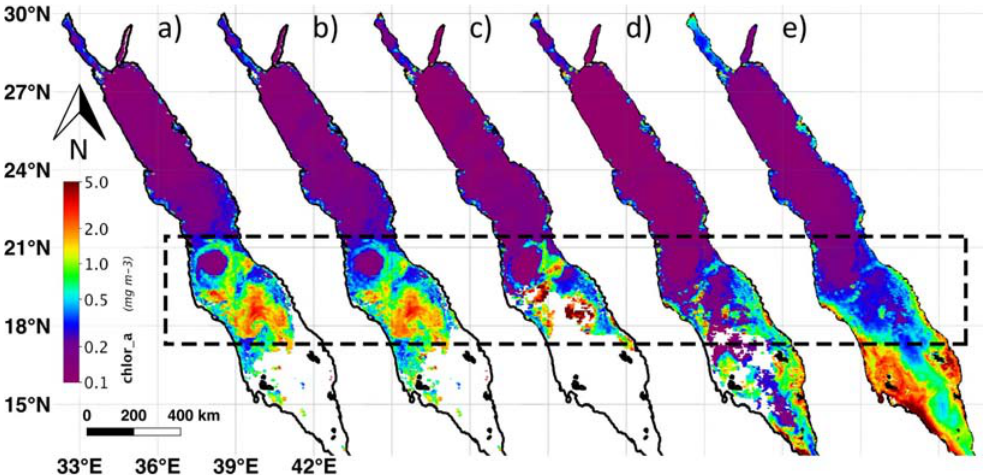
Figure 4. Chl- a concentrations in the Red Sea for different time periods ( a ) The OC-CCI Chl- a (mg m − 3 ) merged level-3 5-day composite, from 25 June 2015 to 29 June 2015, ( b ) the OC-CCI Chl- a merged level-3 monthly composite for June 2015, ( c ) the MODIS Terra Chl- a level-3 monthly composite of June 2015, ( d ) the MODIS Terra Chl- a level-3 monthly climatology composite for June for all years from 2000 to 2015 and ( e ) MODIS Terra Chl- a level-3 4-km annual composite for 2015.